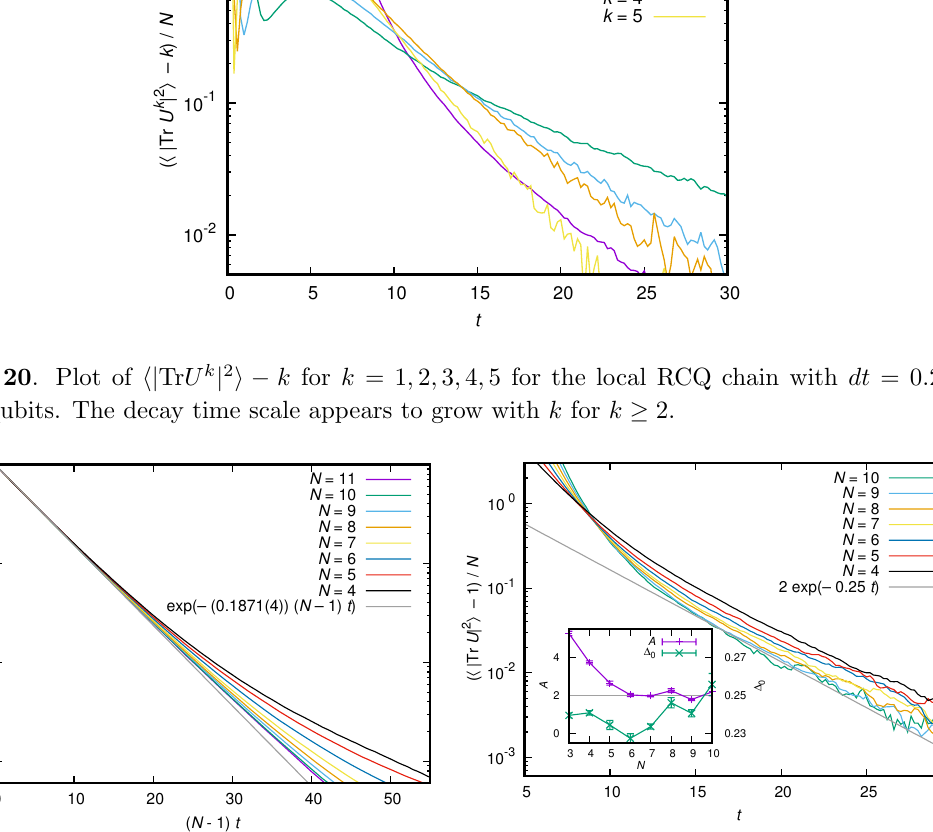
Figure 21 . [Left] Plot of ( hj Tr U j 2 i (cid:0) 1) = (4 N (cid:0) 1) against ( N (cid:0) 1) t for the local RCQ chain with dt = 0 : 2 for N = 11 ; 10 ; 9 ; 8 ; 7 ; 6 ; 5 ; 4 qubits. [Right] Plot of ( hj Tr U j 2 i (cid:0) 1) =N for the local RCQ chain with dt = 0 : 2 for N = 10 ; 9 ; 8 ; 7 ; 6 ; 5 ; 4